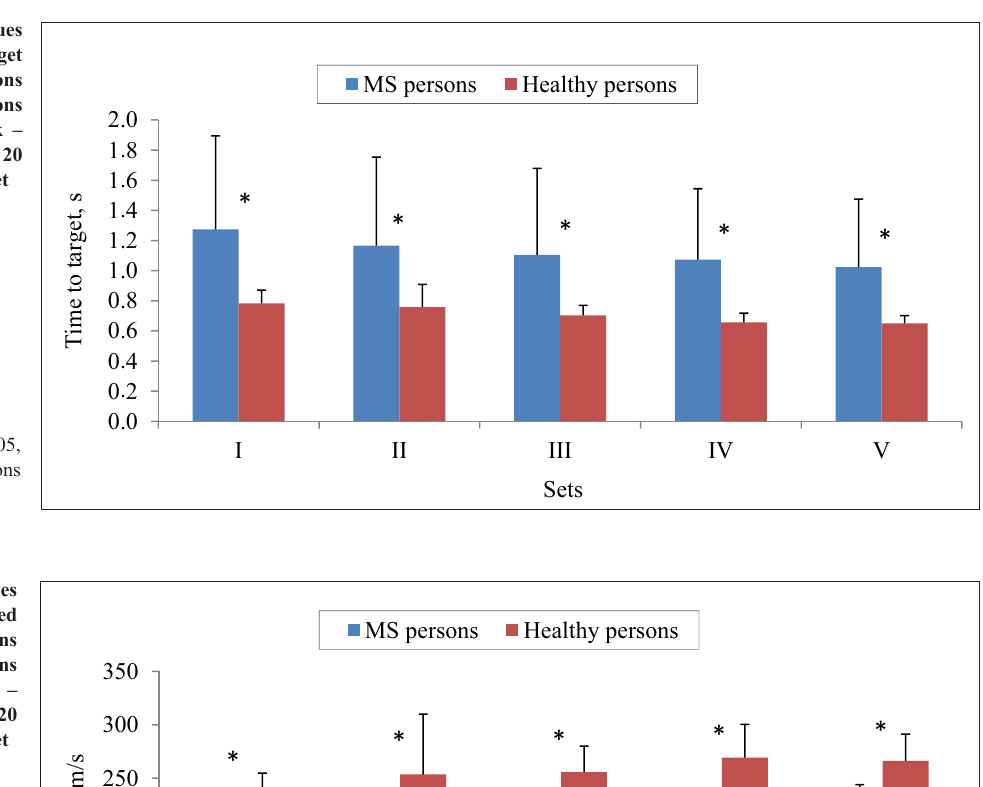
Figure 1. Mean values of time to